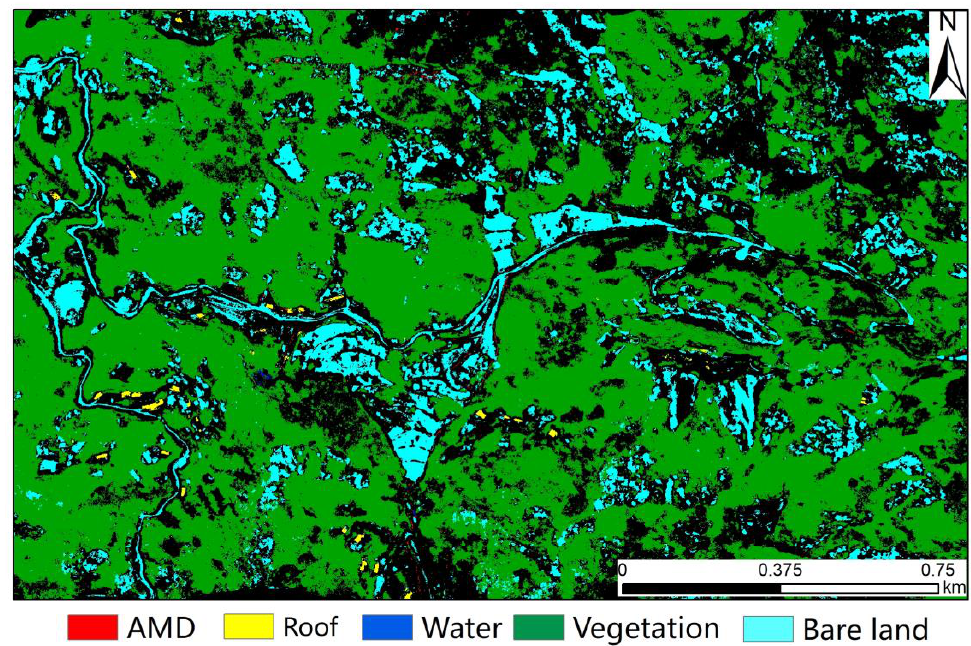
Figure 9. The classification map of U-Net method.